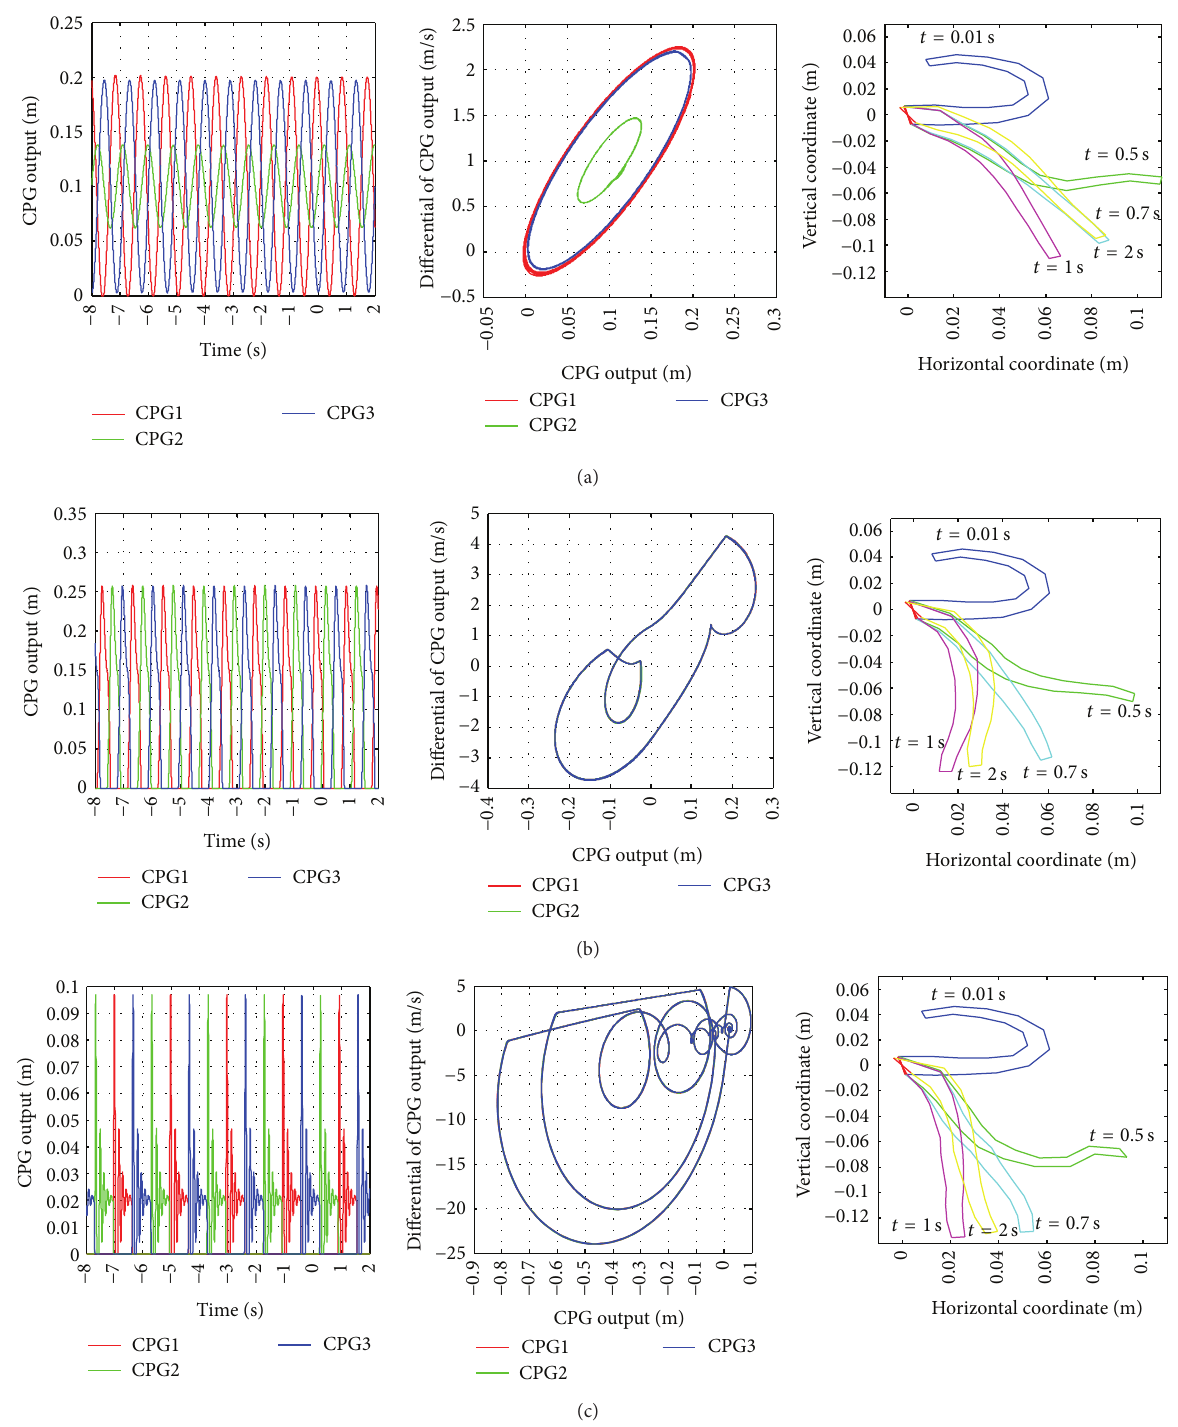
Figure 7: Outputs and phase diagrams of three coupled CPGs and a sequence of octopus arm movements with parameters 𝑑 and 𝑤 (from left to right): (a) 𝑑 = 𝑤 = 3 , (b) 𝑑 = 𝑤 = 5 , and (c) 𝑑 = 𝑤 = 48